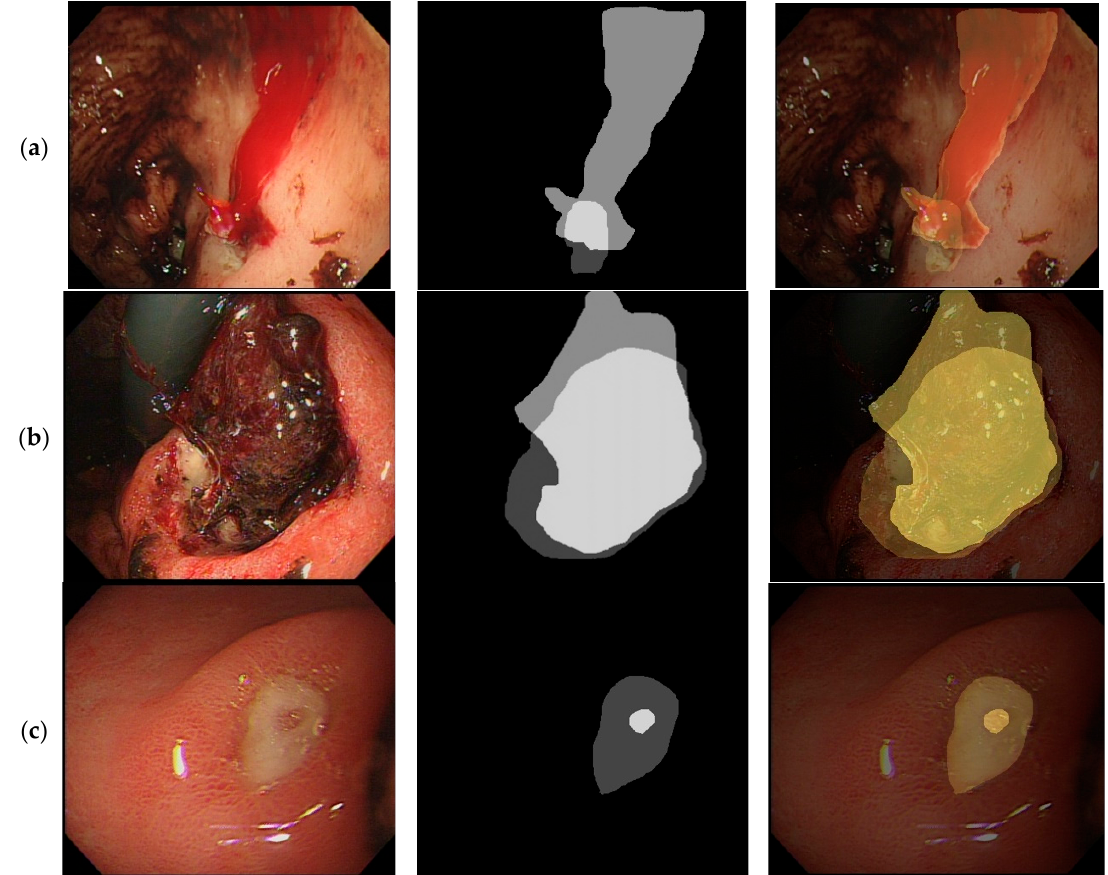
Figure 2. Illustration of the image analysis work of different peptic ulcer images. ( a ). Forrest , I lesion , actively bleeding ulcer. Original image ( left ), image segmented into ulcer/bleeder areas ( middle ), combined image ( right ). ( b ). Forrest IIB lesion , ulcer with adherent clots. Original image ( left ), image segmented into ulcer/bleeder areas ( middle ), combined image ( right ). ( c ). Forrest IIc lesion , ulcer with red spots. Original image ( left ), image segmented into ulcer/bleeder areas ( middle ), combined image ( right